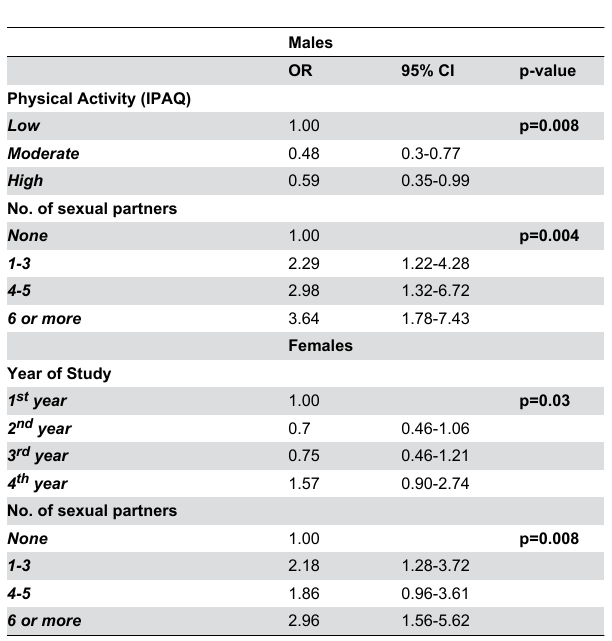
Table 4. Multivariate Logistic Regression: Risk factors associated with above average mental health and well- being (controlling for